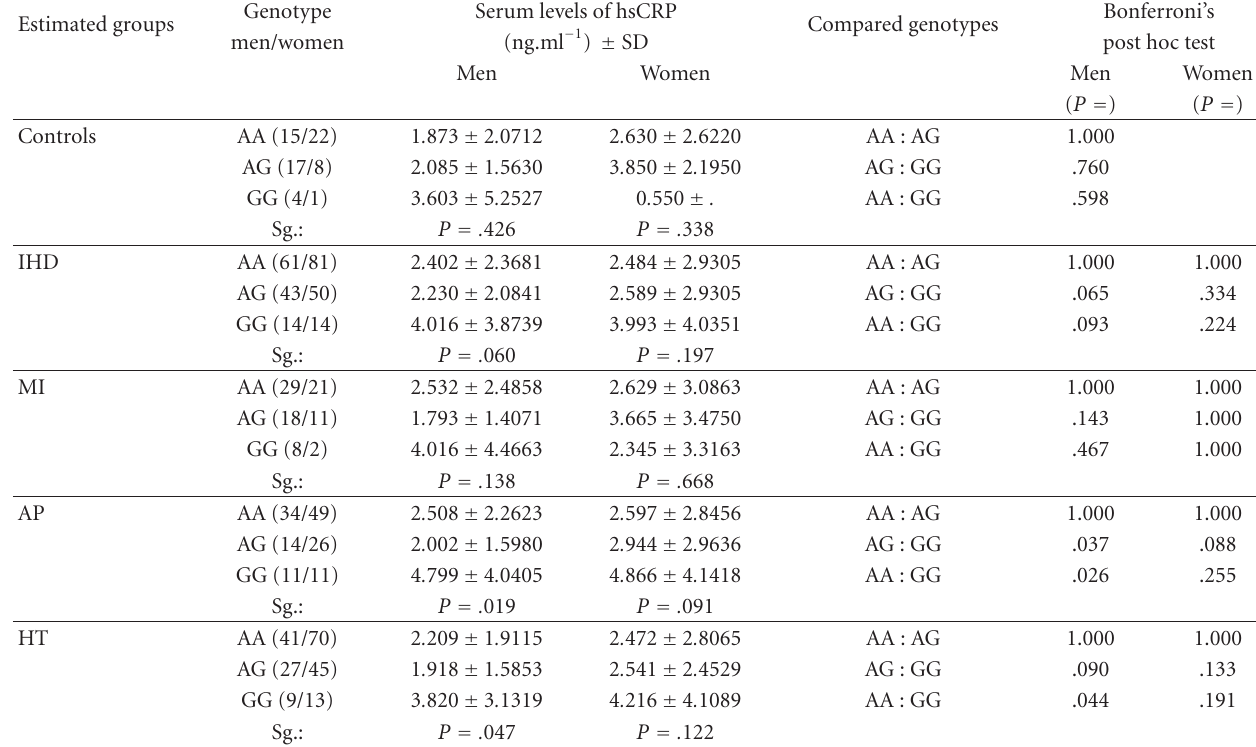
Table 3: Serum levels of hsCRP in patients with IHD, MI, AP, and HT in relation to the tested MCP-1 -2851 (A/G) SNP and to sex. Legend: IHD: ischemic heart disease; MI: myocardial infarction; AP: angina pectoris; HT: hypertension; Sg.: significance; SD: standard